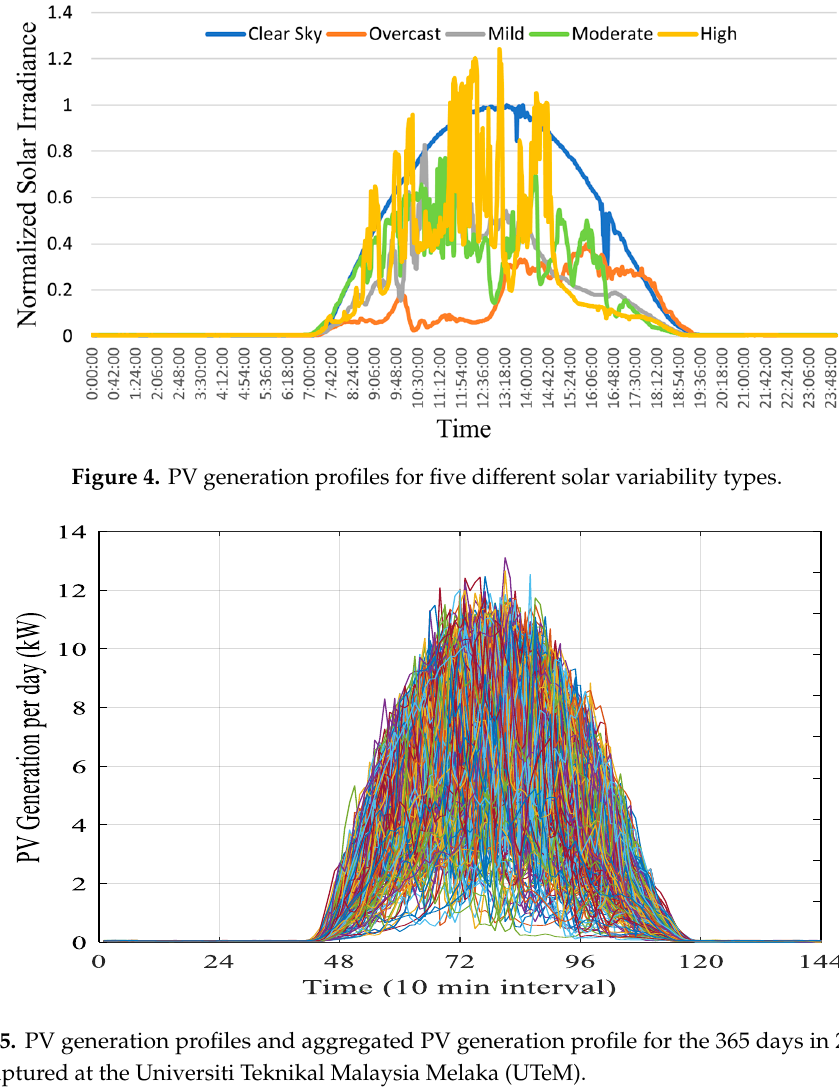
were captured at the Universiti Teknikal Malaysia Melaka (UTeM).